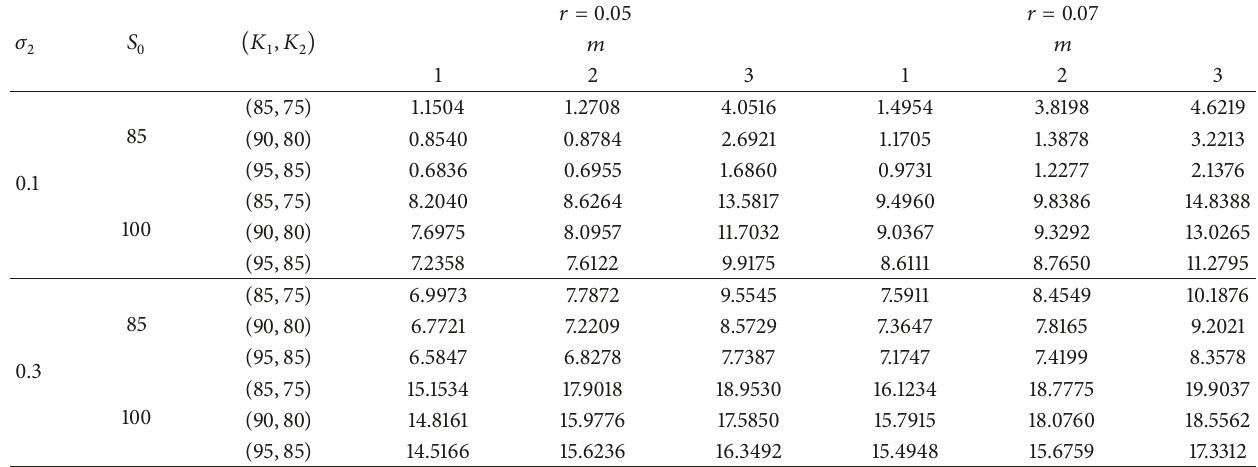
Table 2: Values of the outside reset option with two strike resets and three reset